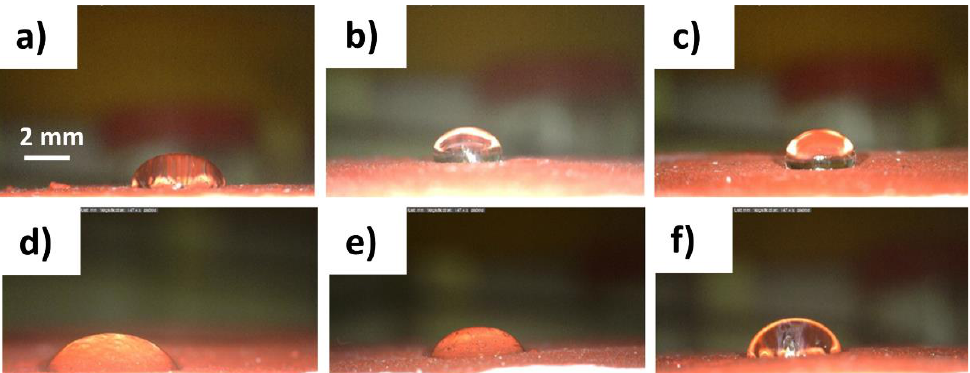
Figure 6. Images of contact angle tests: ( a ) 1 application, ( b ) 2 applications, and ( c ) 3 applications of PRO-ART; and ( d ) 1 application, ( e ) 2 applications, and ( f ) 3 applications of AG09W.